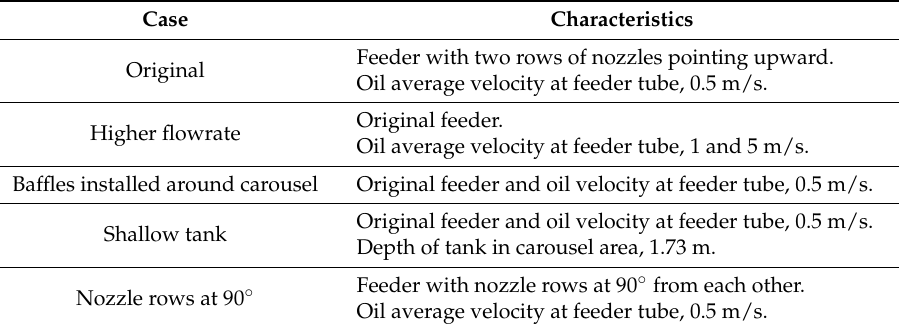
Table 7. Characteristics of the analyzed quenching